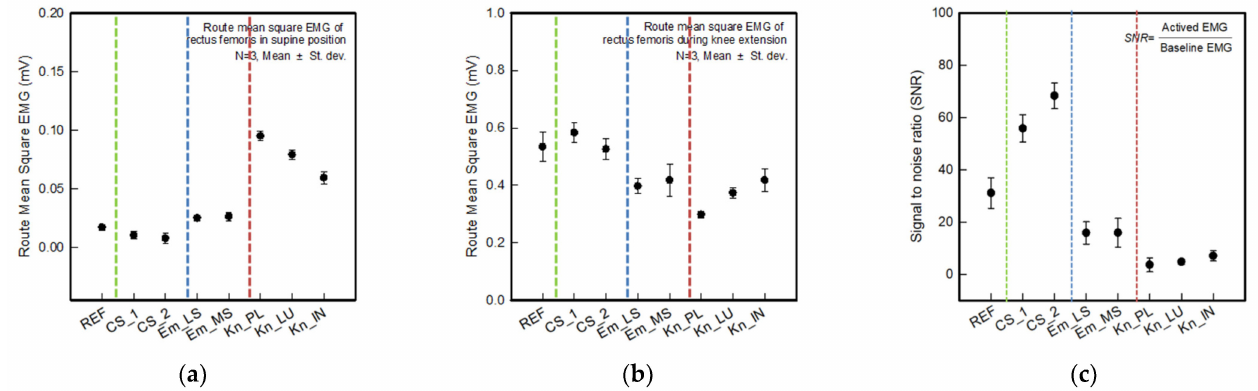
Figure 8. Average rectified sEMG of the baseline during muscle activation for different electrode types. ( a ) Baseline electrode noise; ( b ) sEMG amplitude during muscle contractions exerted by knee extension; ( c ) signal to noise ratio